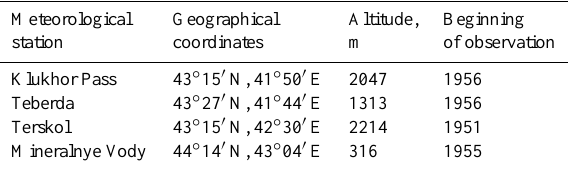
Table 1. Meteorological data used in this work (modified from Solomina et al.,